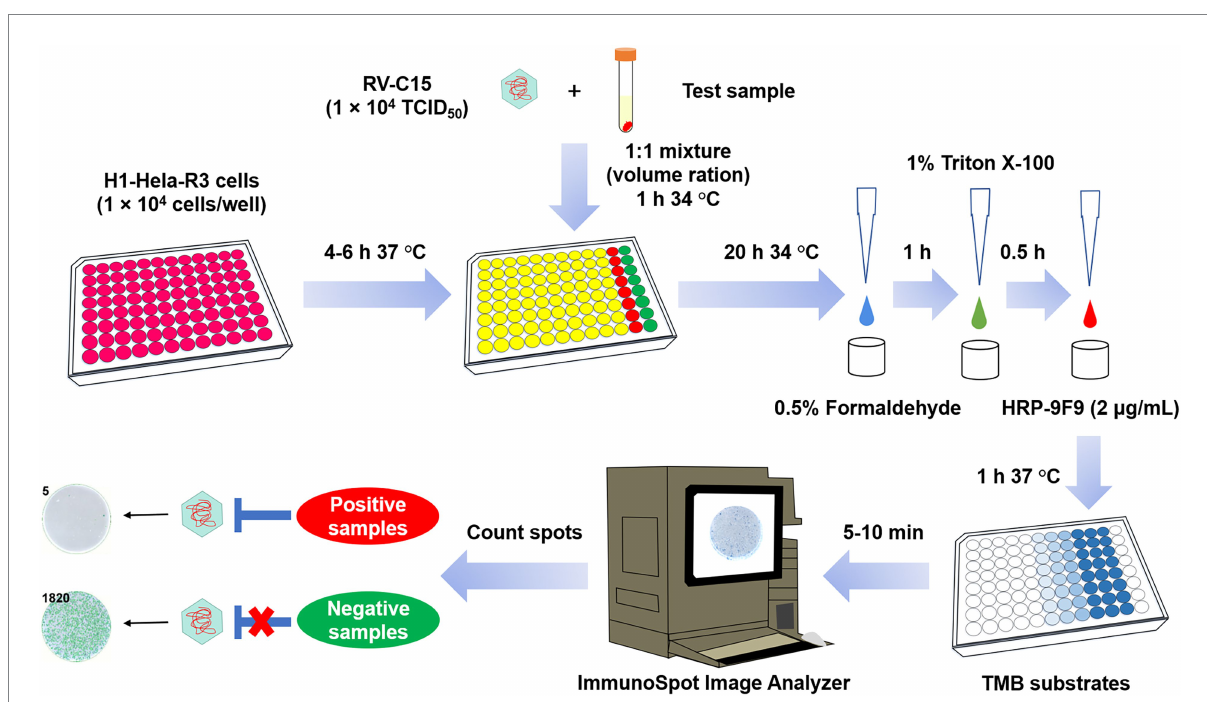
FIGURE 1 Flow diagram of the Nt-ELISPOT for RV-C15. First, H1-Hela-R3 (1 × 10 4 cells/well) were seeded into 96-well plates at least 4 h prior to infection. Then, the serial dilutions of the test samples were mixed with an equal volume of RV-C15 (1 × 10 4 TCID 50 ) and incubated at 34 ° C for 1 h. The mixtures were then added to the cell plates, with the virus control wells and the cell control wells included on the last two columns of each plate. After incubation at 34 ° C for 20 h, cells were fixed with 0.5% formaldehyde and permeabilized with 1% Triton X-100, and then incubated with HRP- 9F9 (2 μ g/ml) at 37 ° C for 1 h. Following at least five washes with PBST (0.05% Tween 20 in PBS), the infected wells were visualized as blue spots after adding the TMB substrates. Spots were counted using an ImmunoSpot@S5 UV Analyzer. The neutralizing titer of the test sample was defined as the highest dilution that completely inhibited more than 50% of the